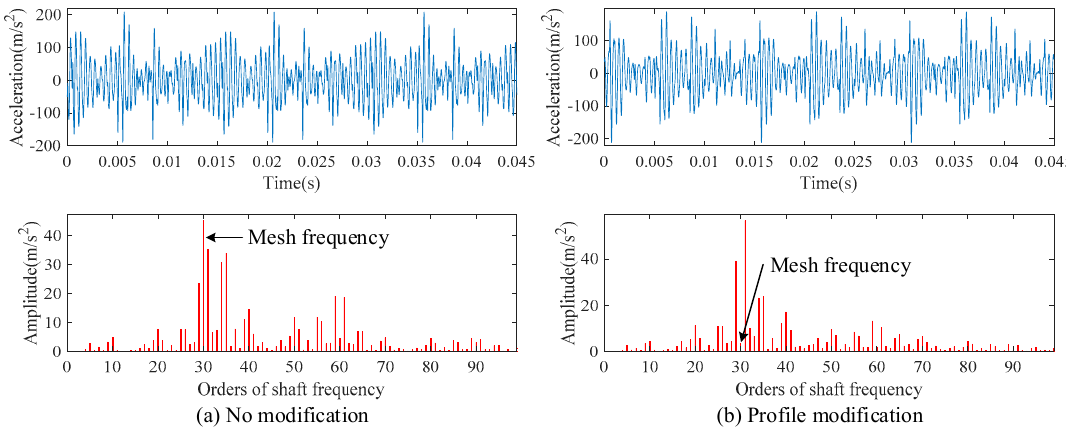
Figure 16. Bearing vibration acceleration along y direction considering random cumulative pitch deviations.